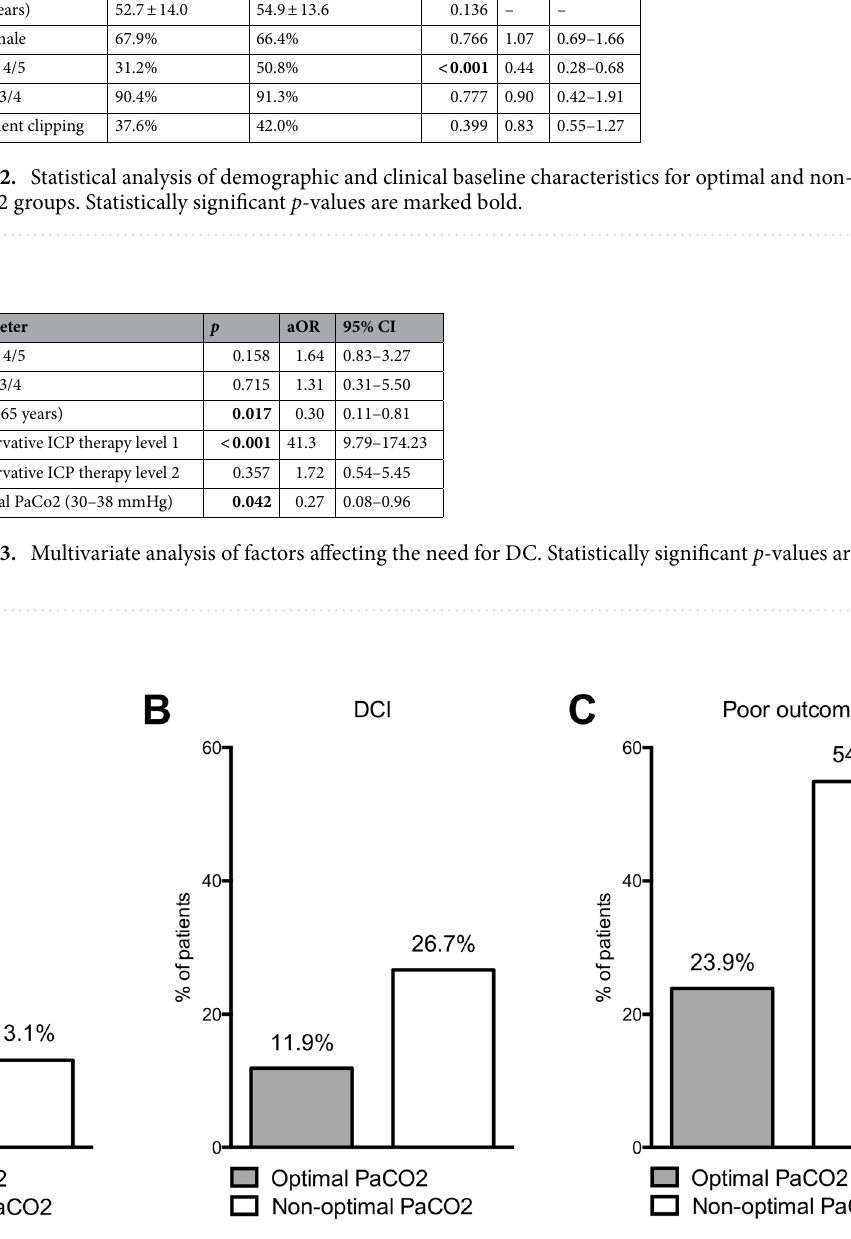
Figure 2. Distribution of risk for ( A ) DC due to refractory ICP increase, ( B ) DCI and ( C ) poor outcome between the optimal PaCO2 and the non-optimal PaCO2